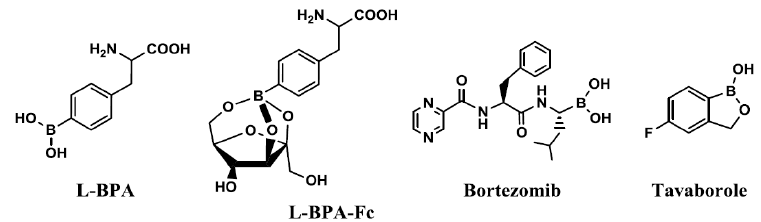
Figure 1. A selection of boron-containing pharmaceuticals.